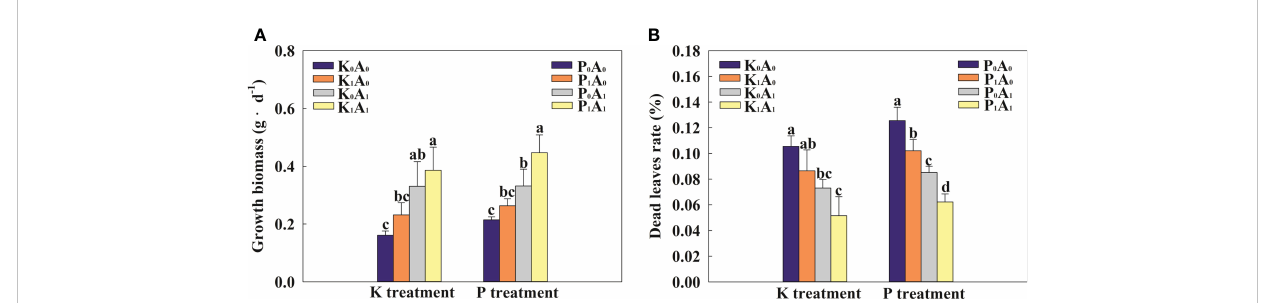
FIGURE 1 Effects of Aspergillus aculeatus on growth biomass (A) and death leaf rate (B) of bermudagrass under K or P de fi ciency stress. K 0 A 0 represents no potassium feldspar and A. aculeatus treatment; K 1 A 0 represents only potassium feldspar treatment; K 0 A 1 represents only A. aculeatus treatment; K 1 A 1 represents potassium feldspar + A. aculeatus treatment; P 0 A 0 represents no tricalcium phosphate and A. aculeatus treatment; P 1 A 0 represents only tricalcium phosphate treatment; P 0 A 1 represents only A. aculeatus treatment; P 1 A 1 represents tricalcium phosphate + A. aculeatus treatment. Columns marked with the same small letter indicate insigni fi cant differences between the four treatment groups ( p <